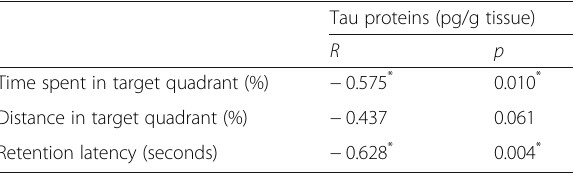
Table 5 Correlation between tau proteins (pg/g tissue) and the time spent in target quadrant (%), the distance in target quadrant (%), and the retention latency (seconds) in the total samples (groups I, II, and III) Tau proteins (pg/g tissue) R p Time spent in target quadrant (%) − 0.575 * 0.010 * Distance in target quadrant (%) − 0.437 0.061 Retention latency (seconds) − 0.628 * 0.004 * Correlations between two quantitative variables were assessed using Pearson ’ s coefficient *Statistically significant at p ≤